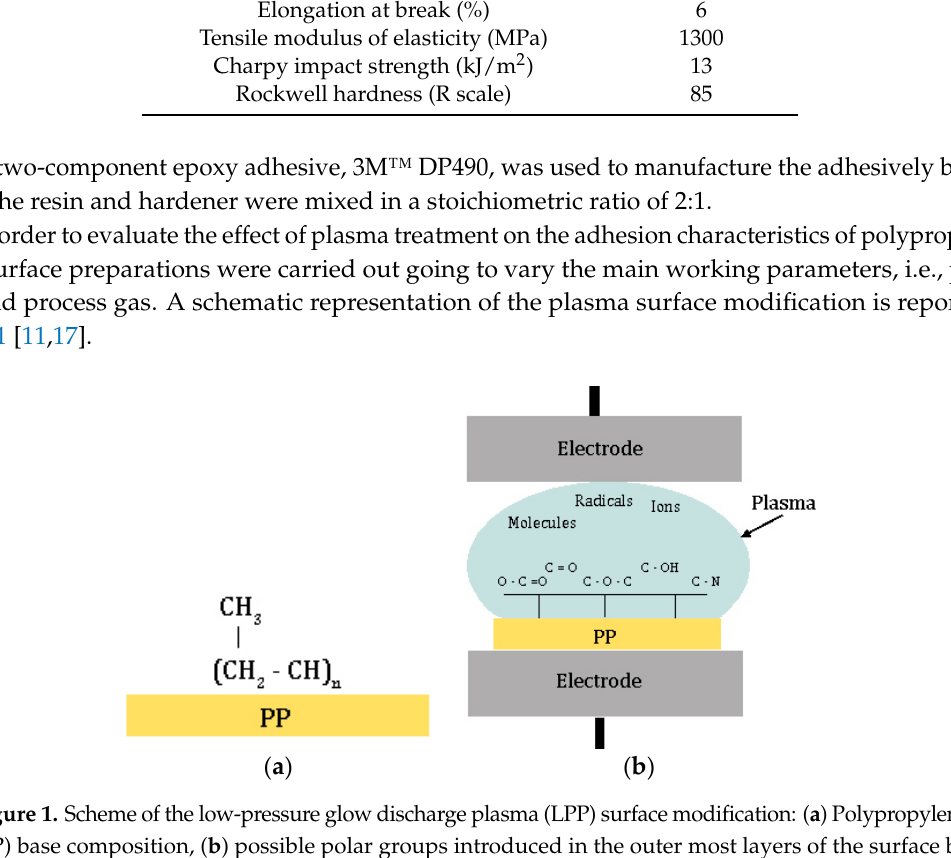
Table 1. Mechanical and thermal properties of the substrates used for the tests.